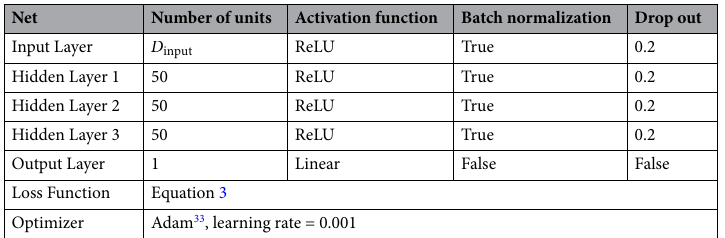
Table 1. MLP neural network used as the predictive model of the forecasts